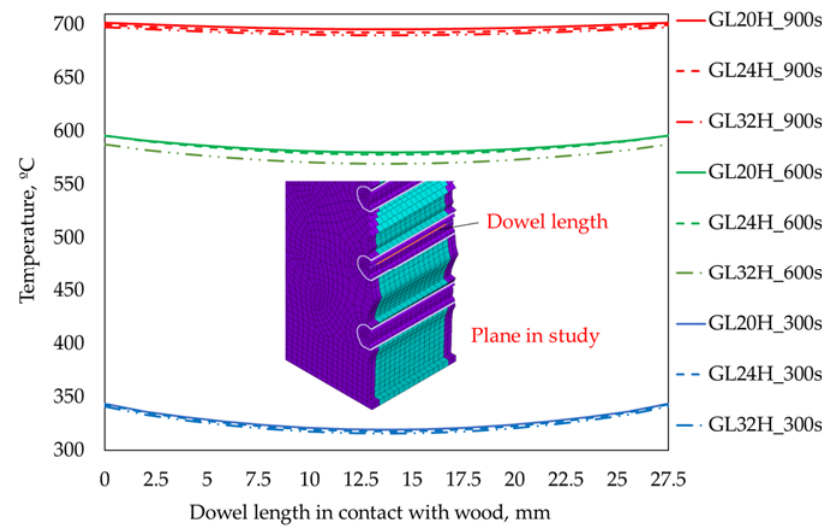
Figure 14. Temperature through the dowel length at 300 s.